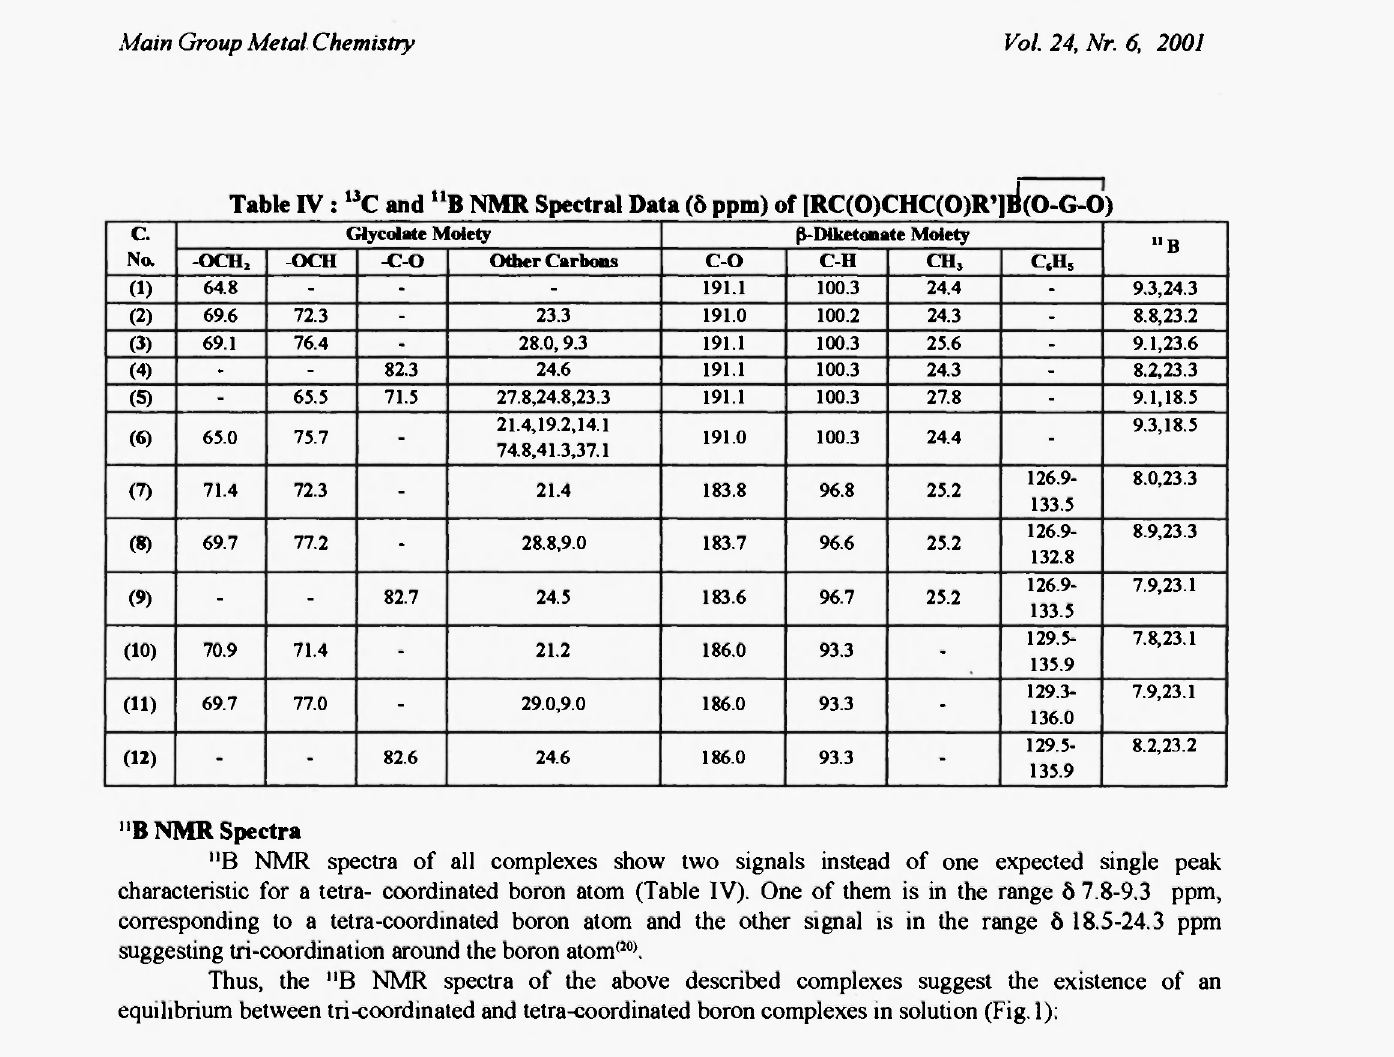
Fig. 1 : Proposed structure of